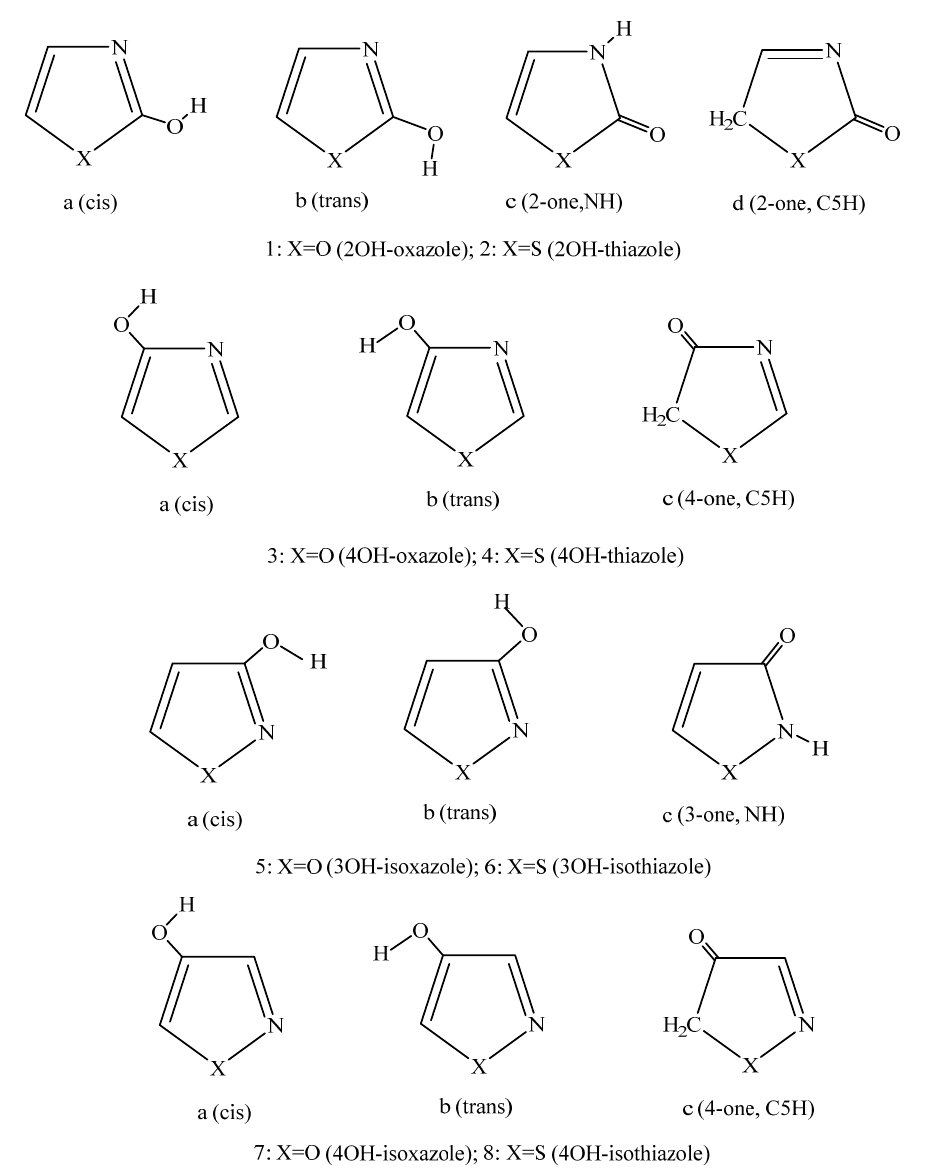
Figure 1. Schematic representation of the structures 1a– 8c in the text.